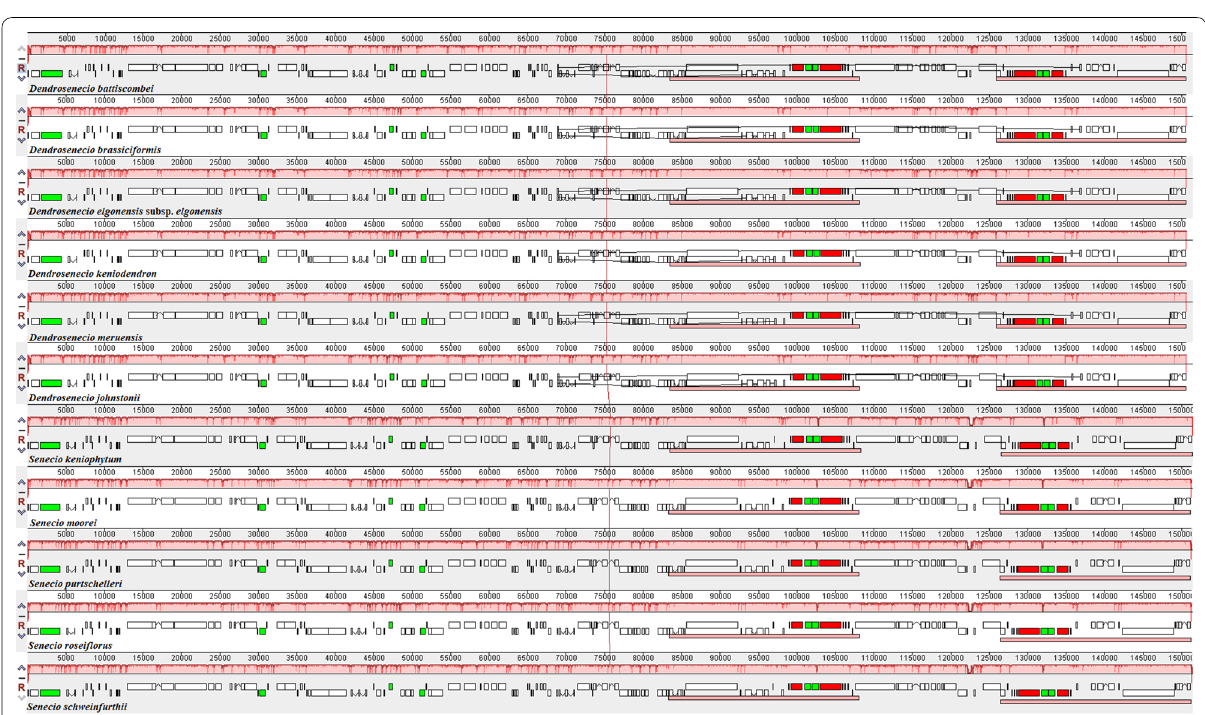
Fig. 5 Comparison of sequence arrangement in the chloroplast genomes of 11 species of Senecioneae (Asteraceae). Conserved orthologs are indicated by locally collinear blocks. Similar blocks among the genomes are coded in one colour and joined by a line. The genes above the line are transcribed in a clockwise direction, those below the line are transcribed towards the counter-clockwise